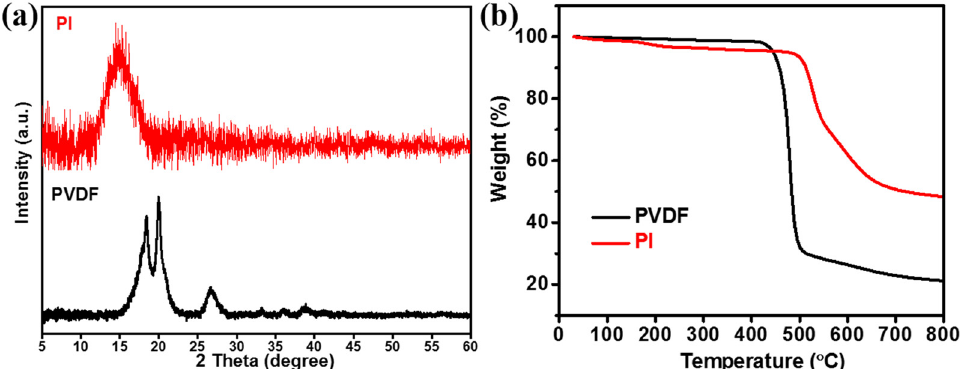
Figure 2: ( a ) XRD patterns and ( b ) TGA curves of PVDF and PI